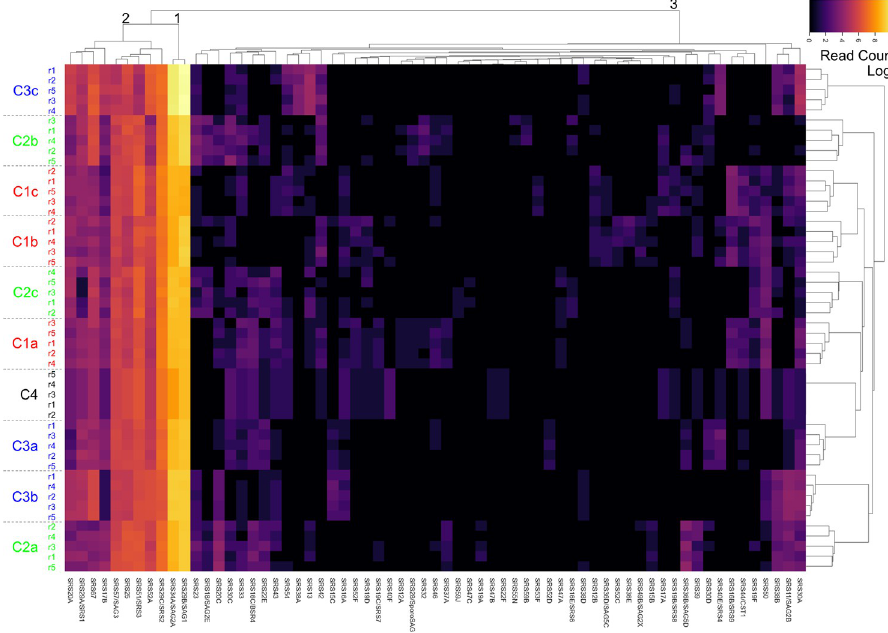
Fig 5. SRS expression among clonally derived tachyzoites. To account for differences in read depth between the samples, the reads for each sample were randomly down-sampled 5 times (r1, r2, etc). The SRS genes were selected from these and then the distances between the samples as regards expression levels for each of these SRS genes were then calculated. The heatmap shows the relative expression level for each detected SRS in all samples, ordered by relatedness between genes (top dendrogram) and samples (right dendogram). The heatmap is log 2 CPM values for the detected SRS genes. Black numbers indicate the groupings of the SRS genes.